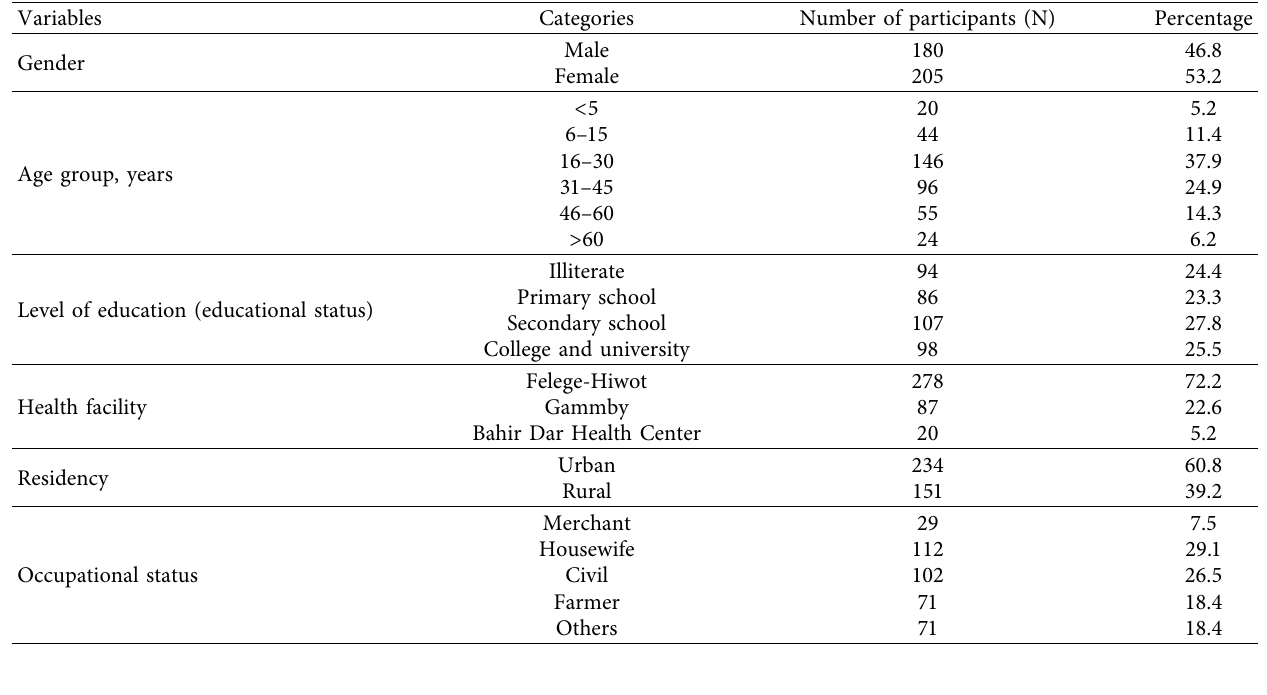
Table 1: Sociodemographic characteristics of UTI-suspected patients who attended Bahir Dar City health institutions, Bahir Dar, Northwest Ethiopia, 2019. Variables